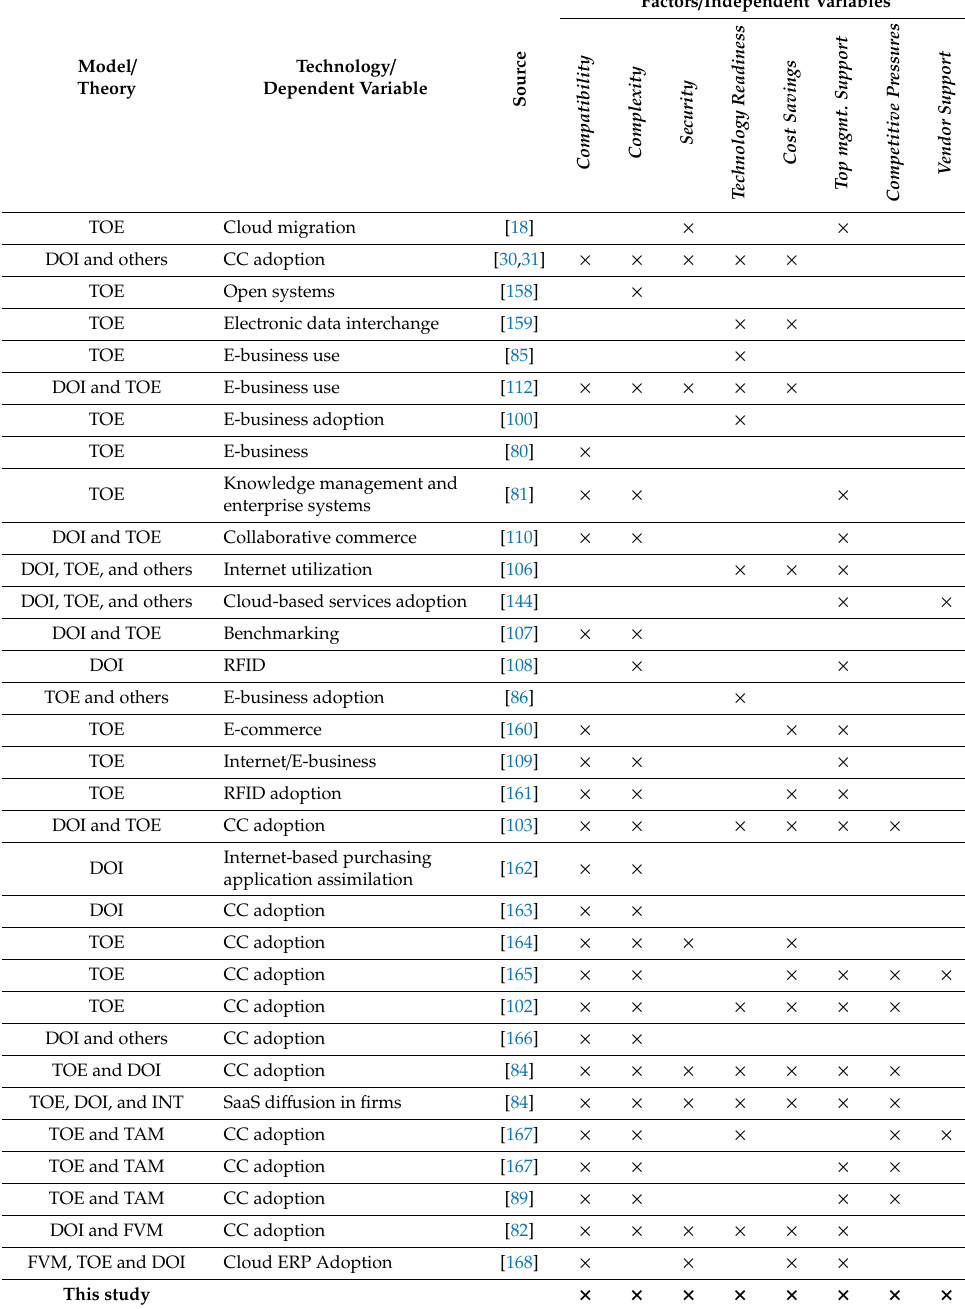
Table 3. Mapping matrix of the model factors from TOE framework and DOI